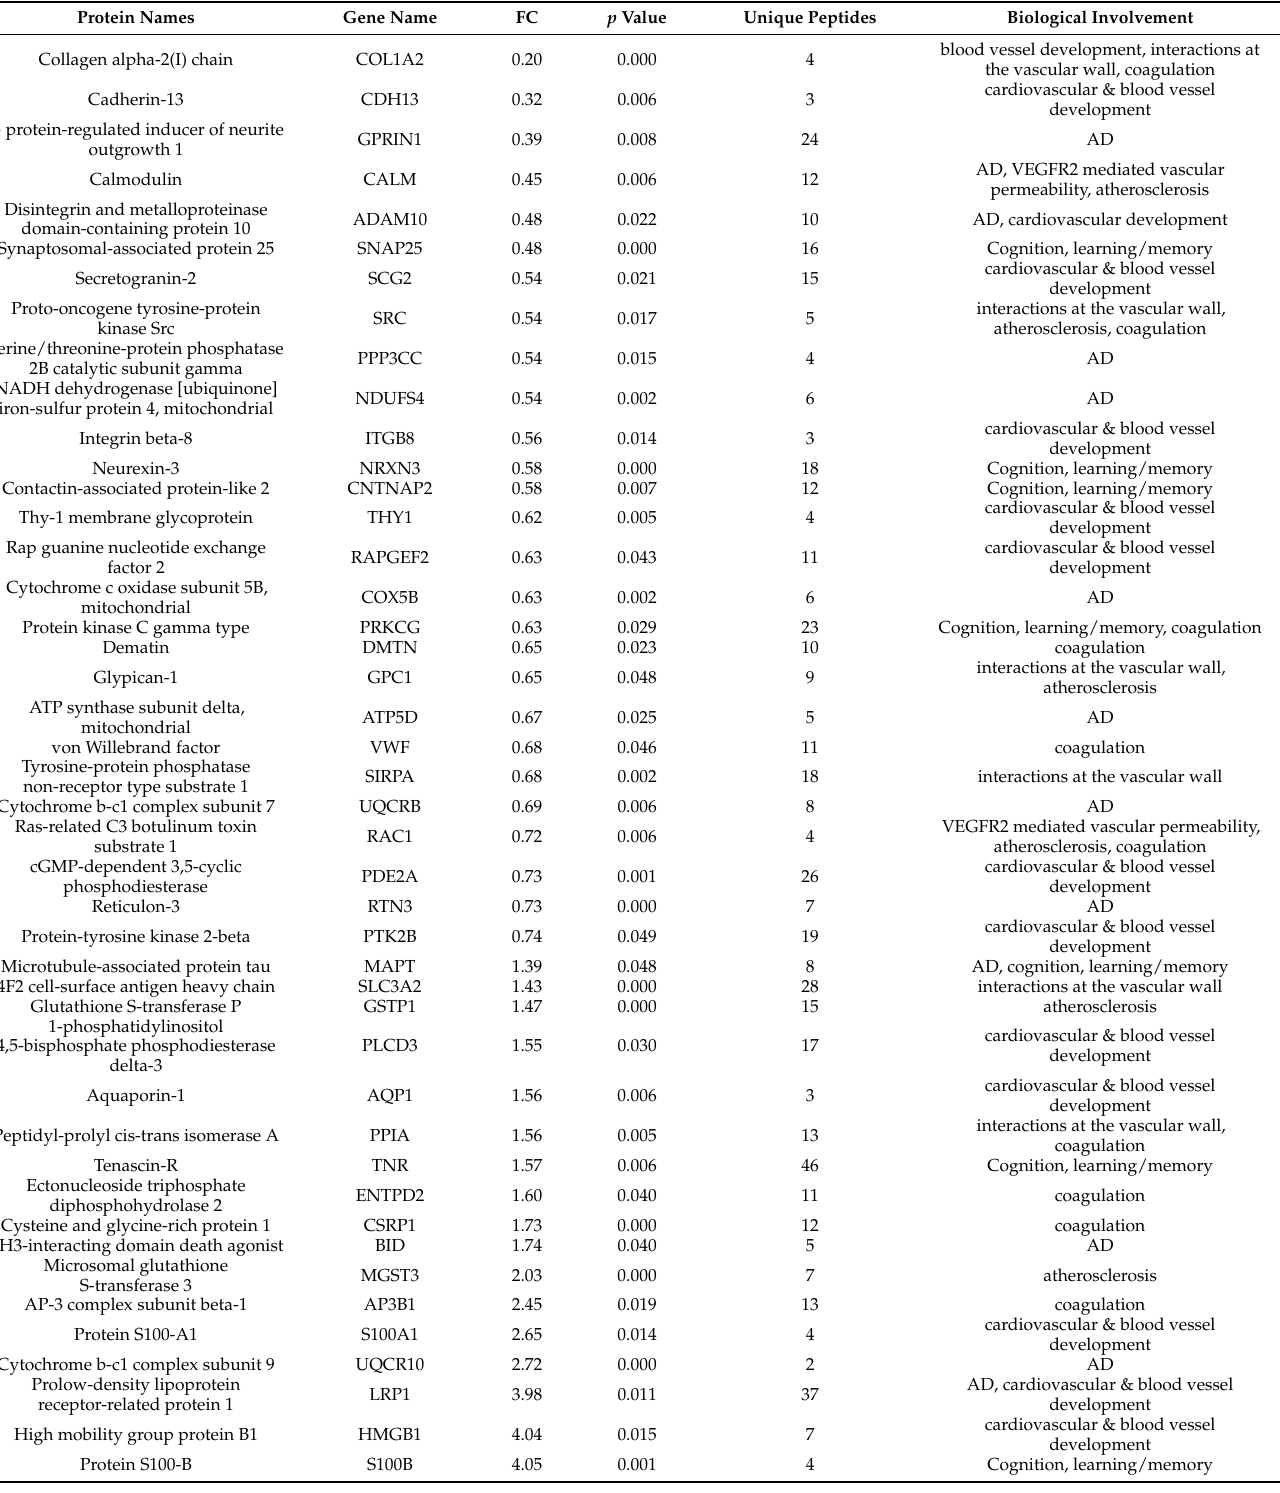
Table 2. OB DEPs in MixD previously related with AD and/or vascular damage. FC; fold change. Unique peptides correspond to the number of exclusive peptides that have been used for the protein quantitation of each protein. The biological involvement information derived from the Metascape output